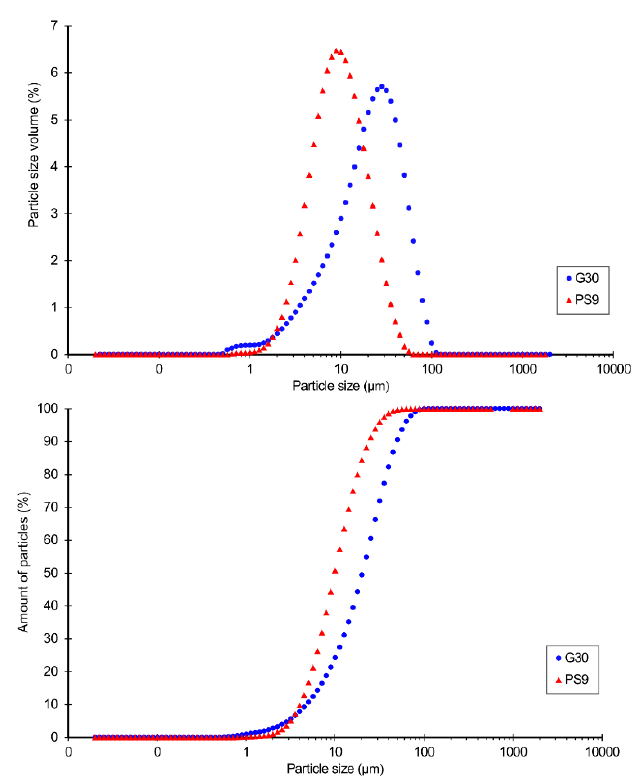
Figure 1. Particle size analysis of PS9 and G30. Differential analysis (up) and cumulative percentage of particles (down).